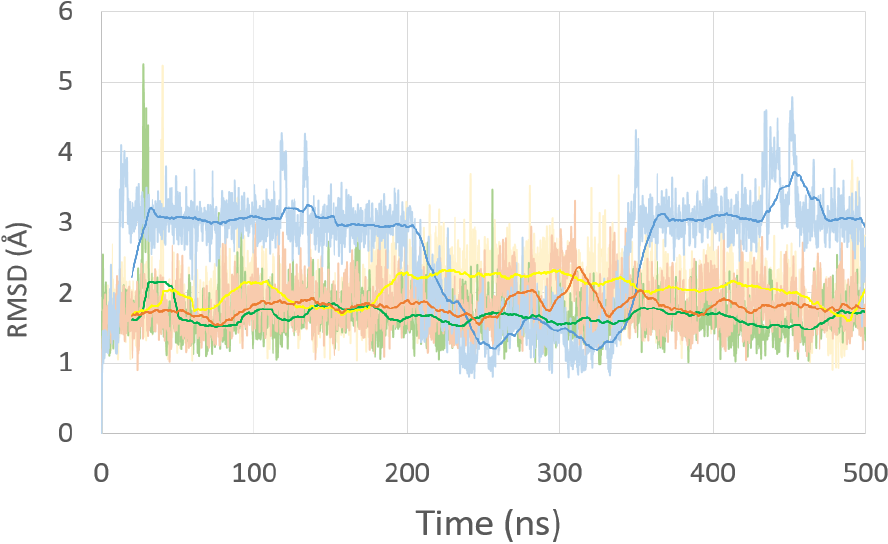
Figure 2. Root mean square deviation (RMSD) of the residues of the native (green), diazonium mod- els (yellow), ICL-A model (brown), and ICL-B model (blue) during 500 ns of MD simulation. models (yellow), ICL-A model (brown), and ICL-B model (blue) during 500 ns of MD